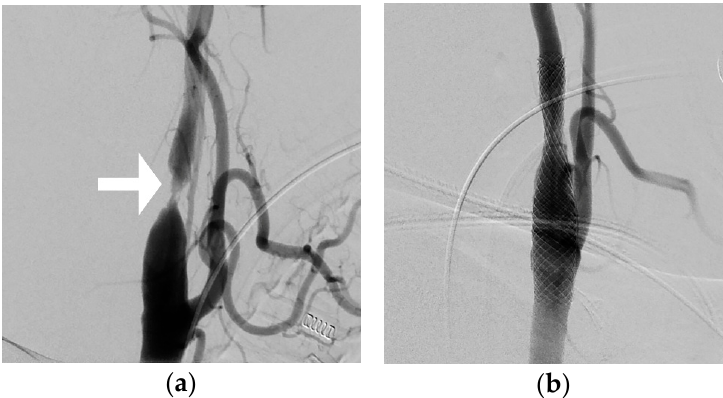
Figure 3. Digital subtraction angiography (DSA) example of a carotid artery stenosis patient (no. 10) before and after CAS treatment. Image ( a ) shows the stenotic part of the internal carotid artery (ICA) marked with a white arrow, while image ( b ) shows the same segment with a slightly di ff erent image projection after CAS